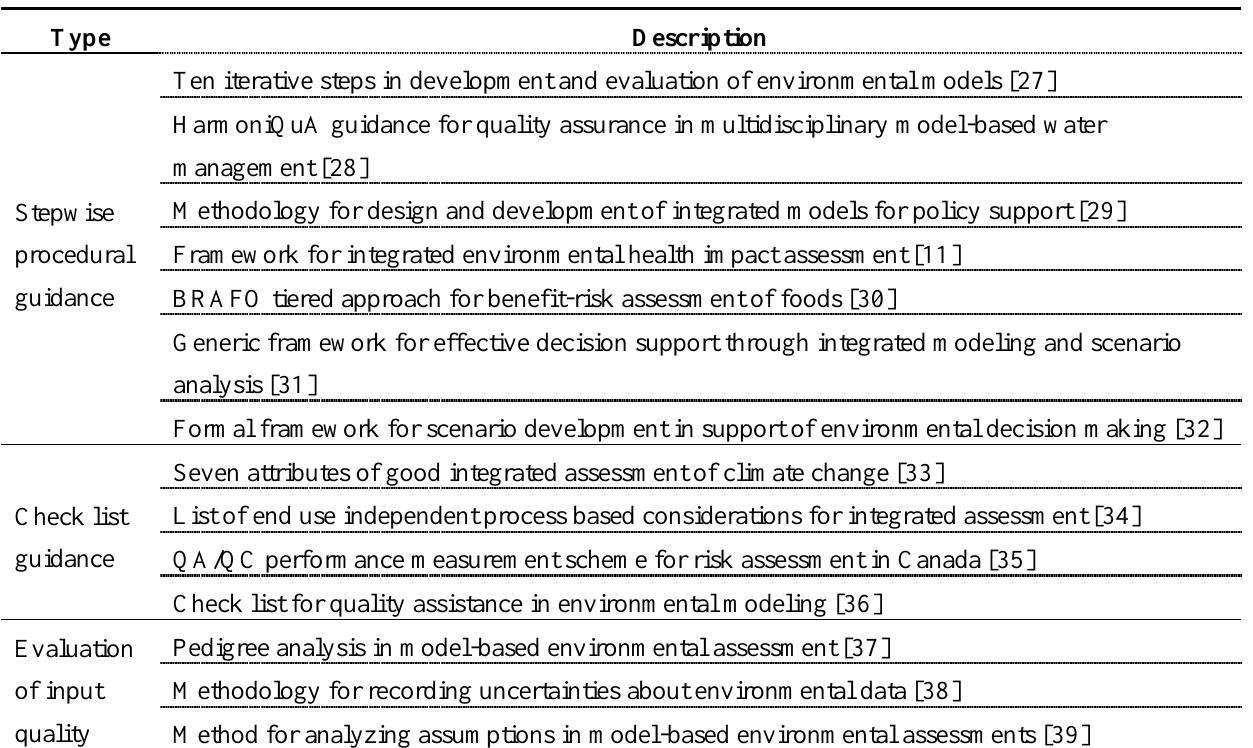
Table 1. Examples of quality assurance/control perspective to assessment and model